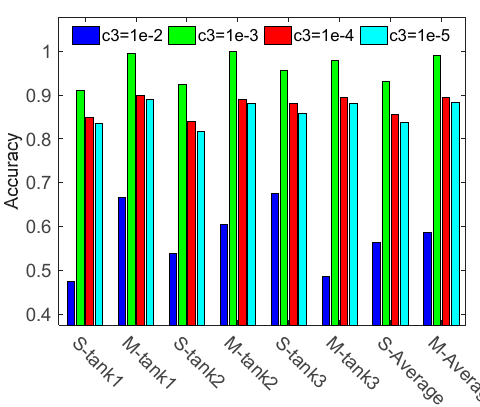
. The ACC results of three tanks are shown in Figure 4.